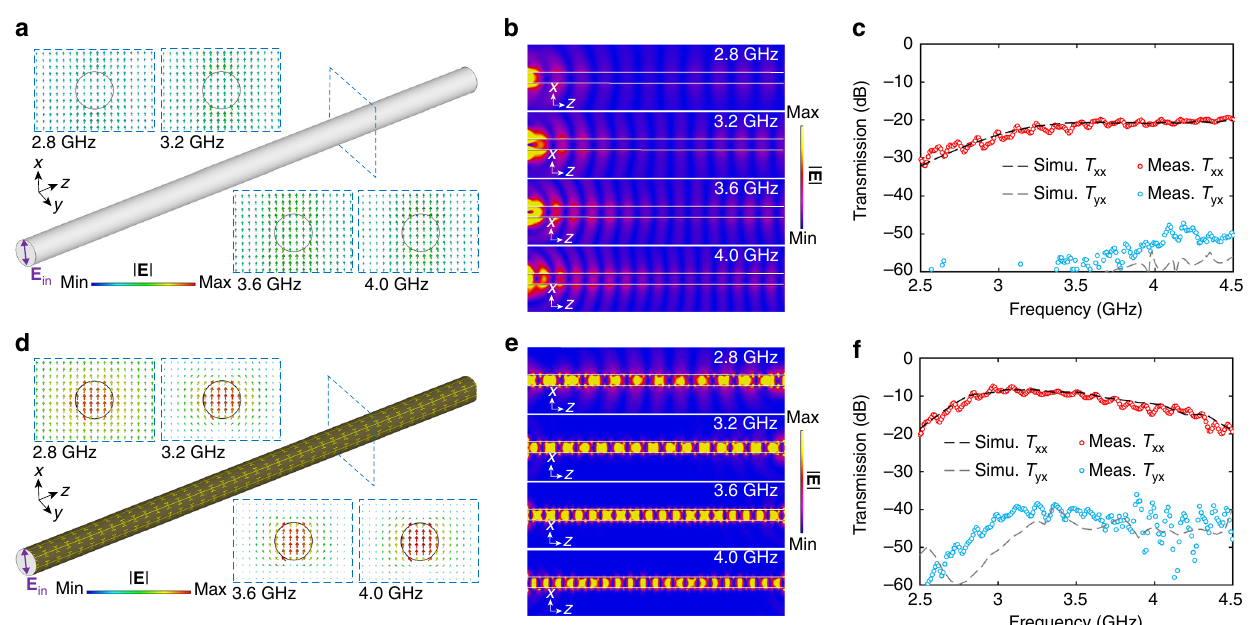
Fig. 2 A sub-wavelength dielectric rod waveguide with a single-layer metasurface coating. Snapshots of the vector electric fi eld distribution in the x - y plane at 2.8, 3.2, 3.6, and 4.0 GHz for a the bare Te fl on rod waveguide and d the Te fl on rod waveguide coated by the metasurface guiding layer when excited by an x polarized probe. Snapshots of electric fi eld distribution in the x - z plane at 2.8, 3.2, 3.6, and 4.0 GHz for b the bare Te fl on rod waveguide and e the Te fl on rod waveguide coated by the metasurface guiding layer. Measured and simulated co-polarized ( T xx ) and cross-polarized ( T yx ) transmission between the transmitting and receiving probes for c the bare Te fl on rod waveguide and f the Te fl on rod waveguide coated by the metasurface guiding